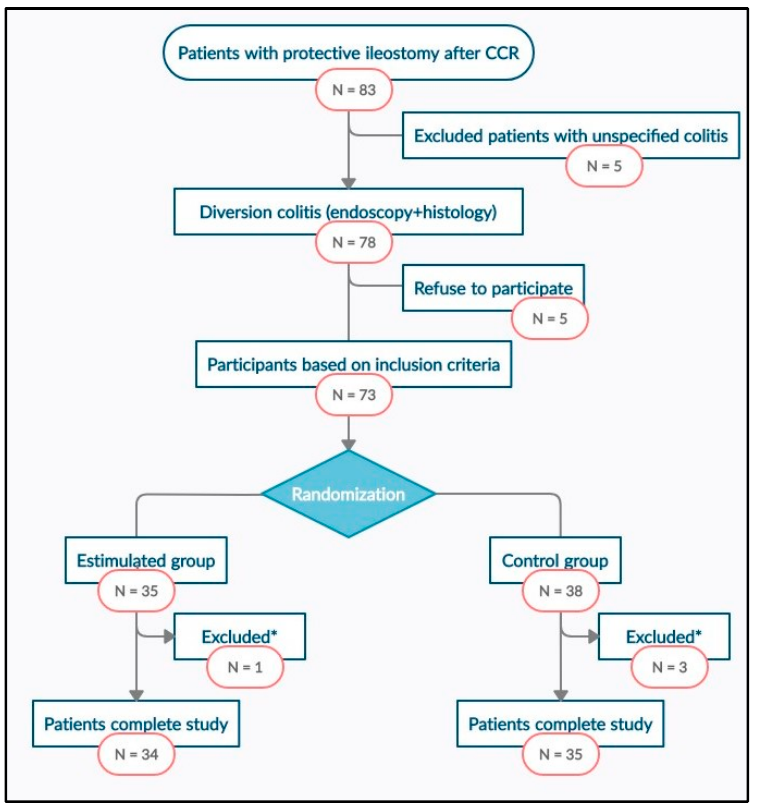
Figure 1. Study flowchart. CRC: Colorectal Cancer. *: excluded patients with an anastomotic leak.